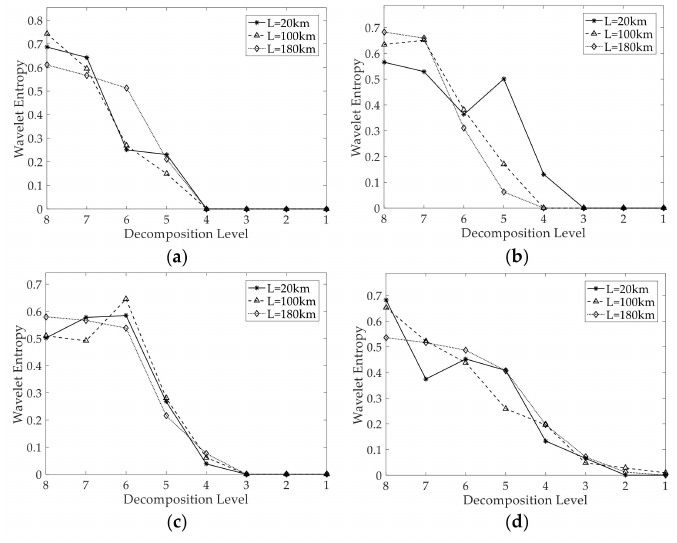
Figure 13. Effect of distance. ( a ) PGF; ( b ) PPF; ( c ) LD; ( d )